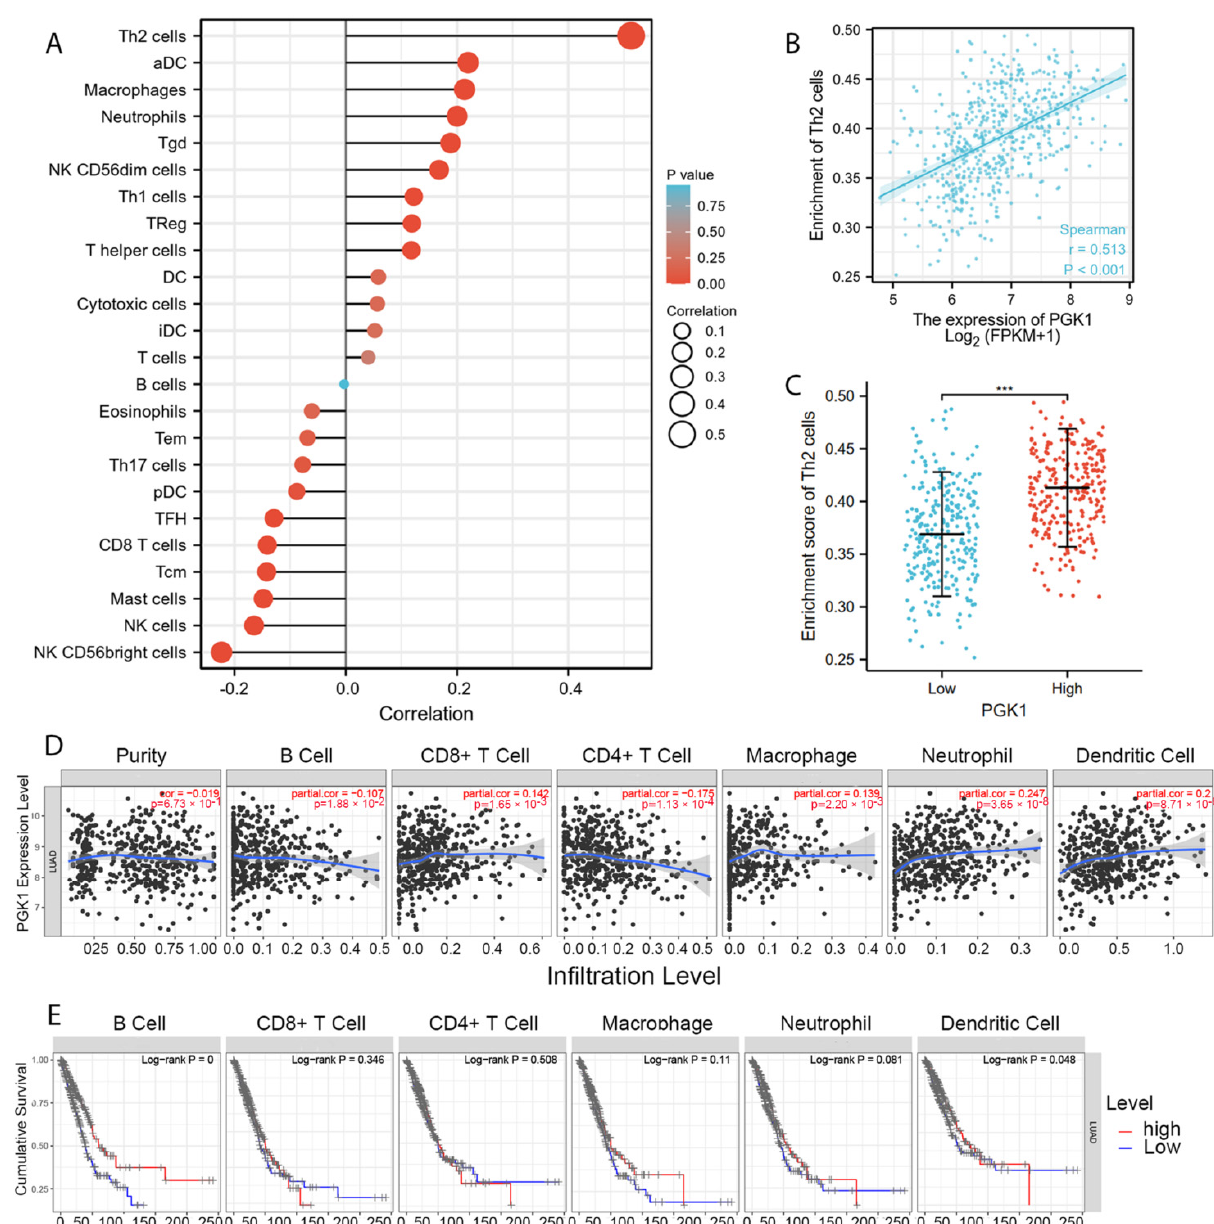
Figure 6. PGK1 expression was linked to immune infiltration in the LUAD microenvironment. ( A ) Forest plots reveal a positive relationship between PGK1 and 13 immune cells, as well as a negative relationship between PGK1 and 11 immune cell types. The size of the dots represents the absolute value of the Spearman’s r. ( B ) Relationship between Th2 cell relative enrichment score and PGK1 expression level (TPM). ( C ) Th2 cell infiltration in the presence of low and high PGK1 expression. ( D ) Relationship between PGK1 expression and immune infiltration in LUAD. ( E ) Kaplan–Meier plots utilized to examine LUAD immune infiltration and overall survival rate. *** p < 0.001.